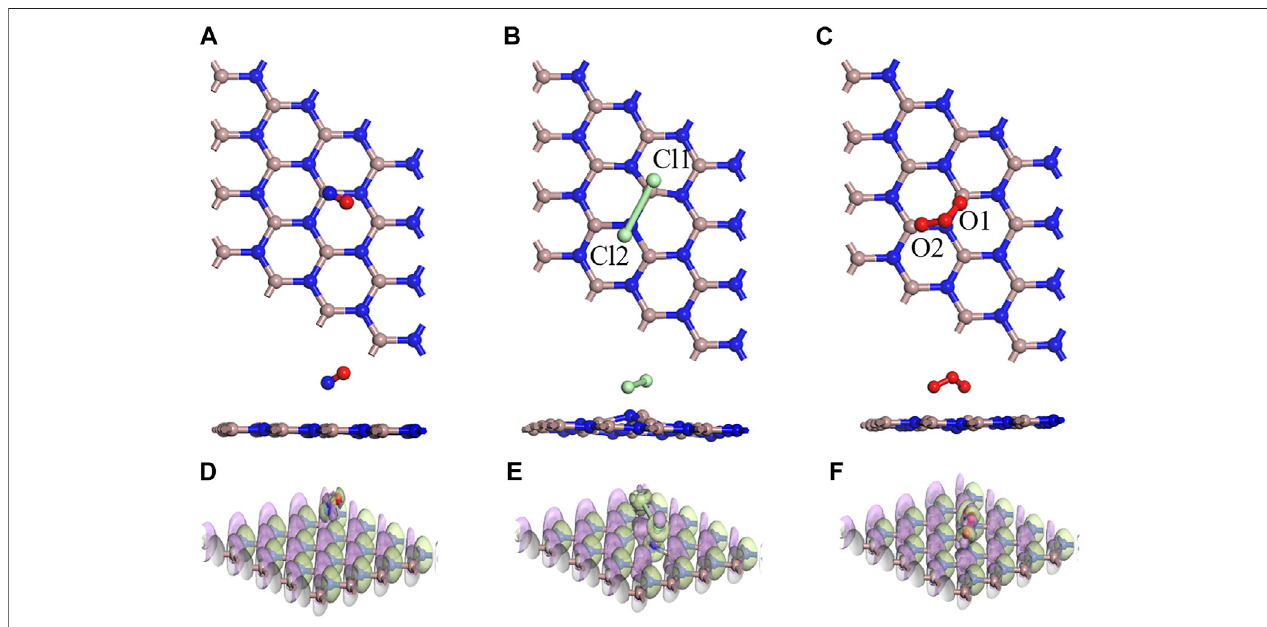
FIGURE 5 | Optimized structures for (A) NO, (B) Cl 2 , and (C) O 3 on the GaN surface and EDD for (D) NO, (E) Cl 2 , and (F) O 3 on the GaN surface (purple regions indicate loss of electrons, and green regions represent obtained electrons in EDD).